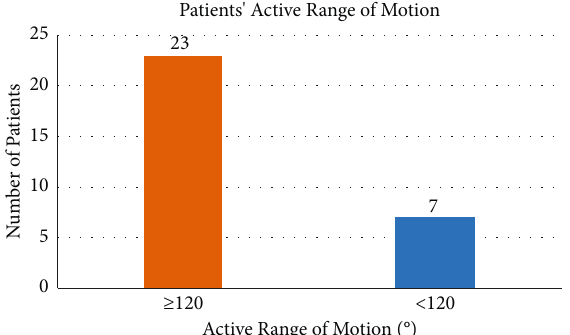
Figure 3: Range of motions among virtual clinic